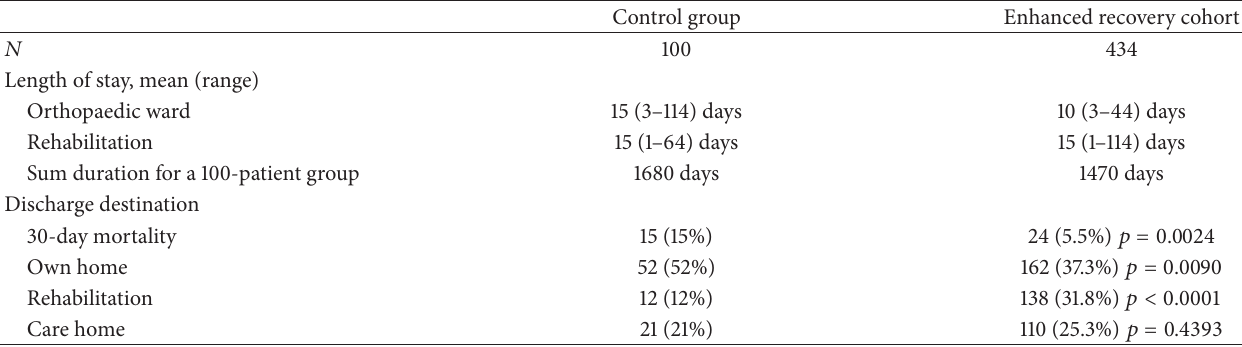
Table 2: Patient outcomes for the control group and the enhanced recovery